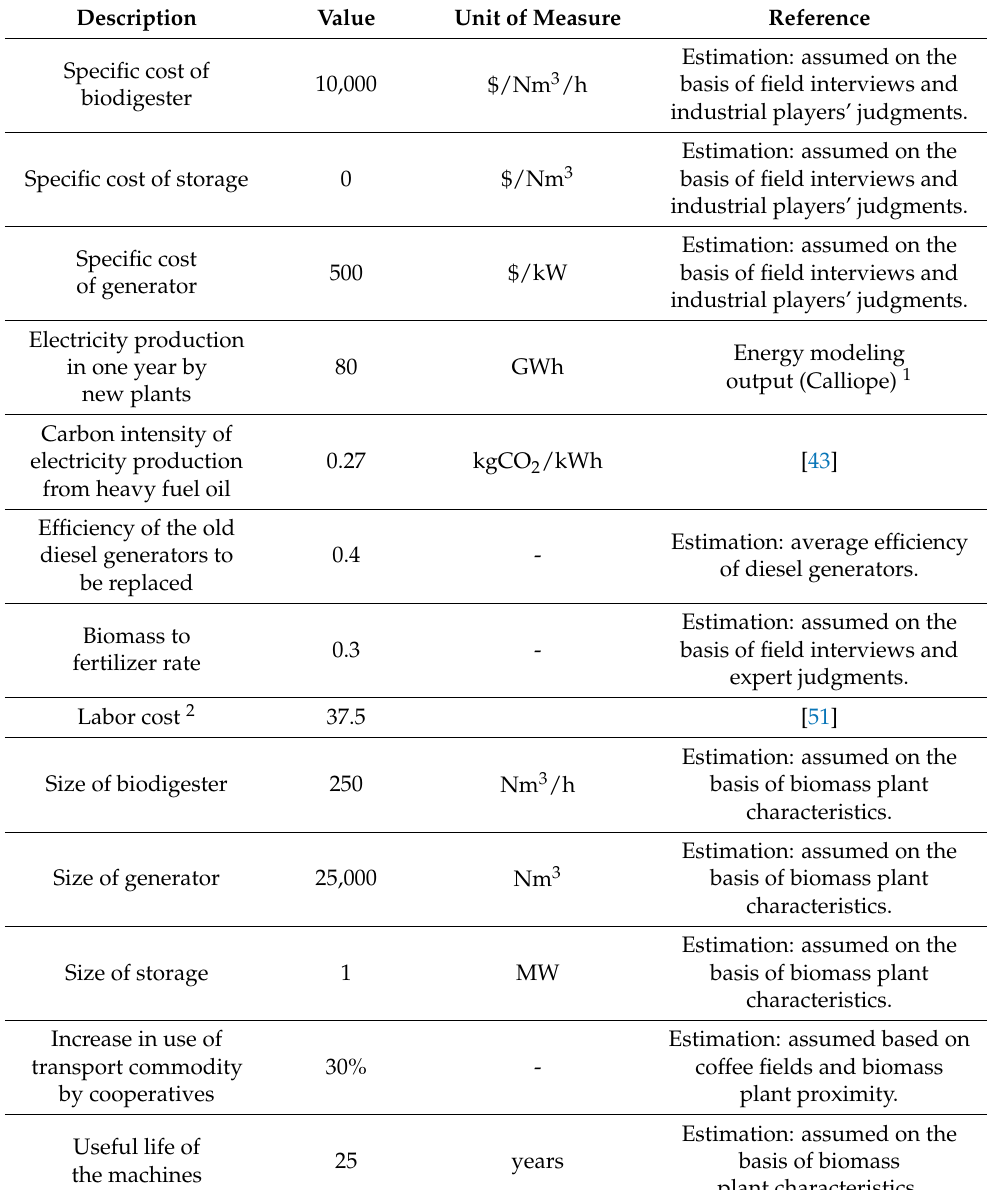
Table 3. Input parameters for biomass powerplant